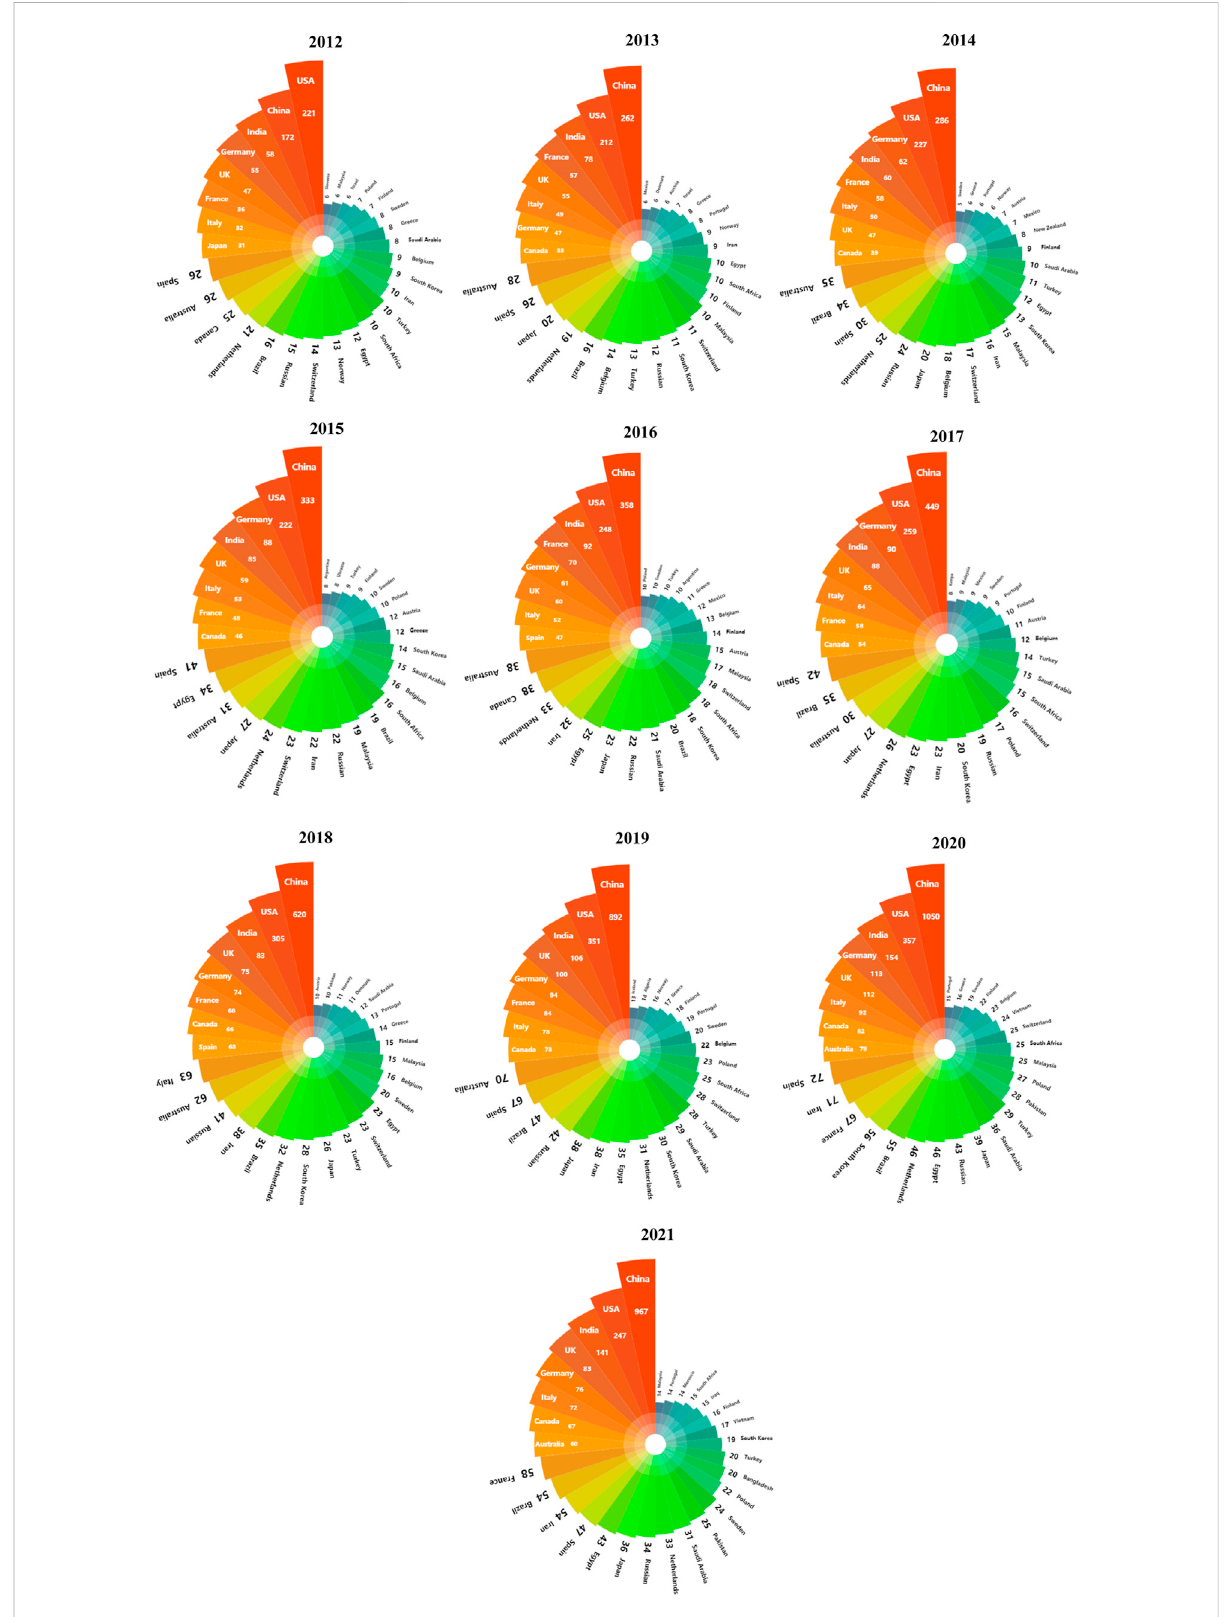
FIGURE 6 Top 30 countries with the most active output of remote sensing